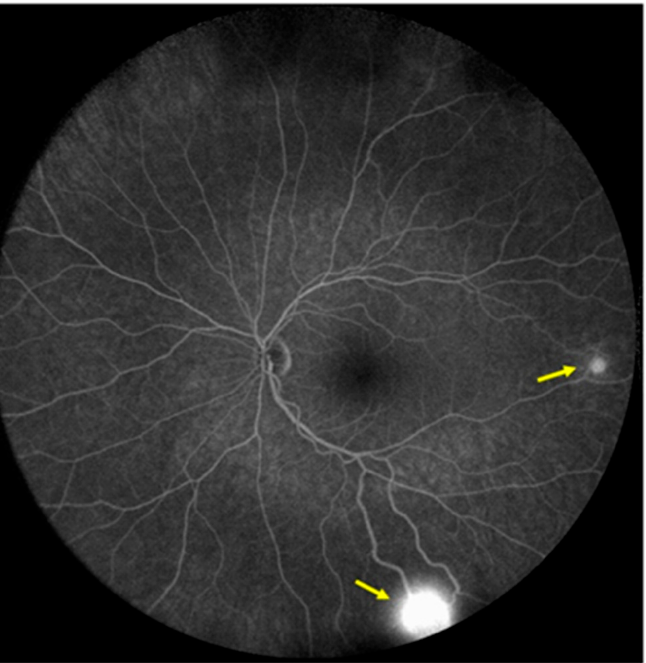
Figure 5. Fluorescein angiography image of the patient’s left eye fundus; yellow arrows show retinal hemangioblastomas.